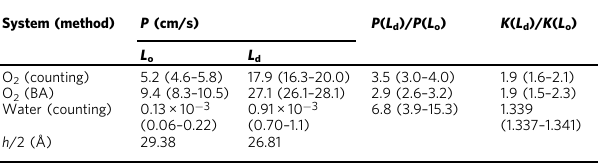
Table 1 Permeabilities and partition coef fi cients from